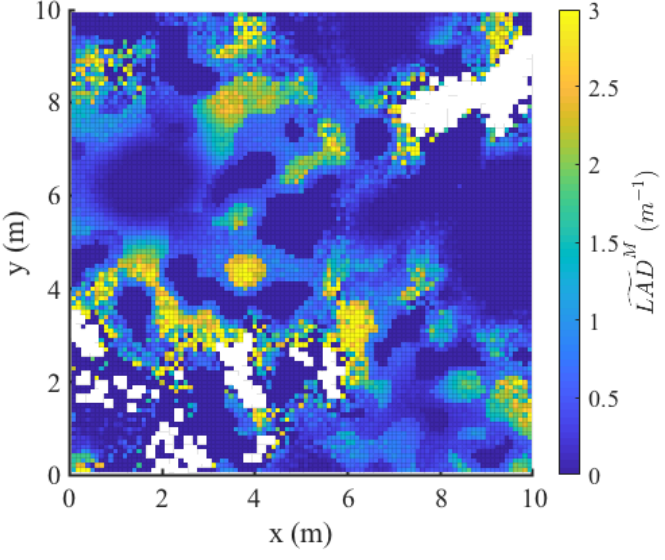
M (cid:93) LAD Figure A2. Estimated horizontal distribution of at z = 6 m. This distribution could directly be compared to LAD ref in Figure A1b. Blank pixels correspond to unexplored voxels, which revealed Figure A2. Estimated horizontal distribution of 𝐿𝐴𝐷̃ 𝑀 at z =6 m. This distribution could directly be occluded locations in the compared to 𝐿𝐴𝐷 𝑟𝑒𝑓 in Figure A1b. Blank pixels correspond to unexplored voxels, which revealed occluded locations in the canopy.